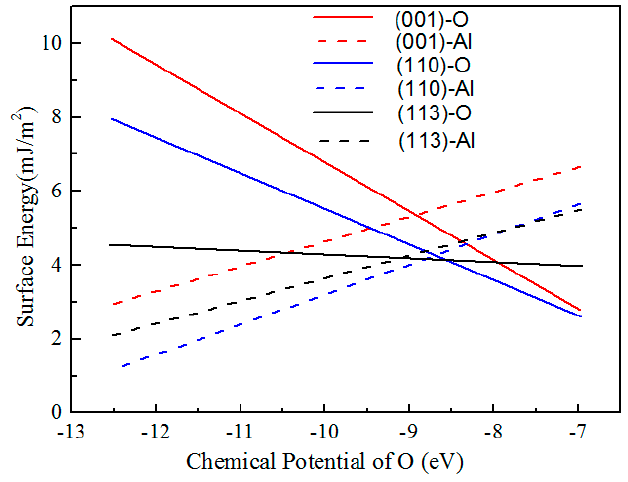
Figure 3. Surface energies for various surface of Al 2 O 3 versus chemical potential of oxygen.